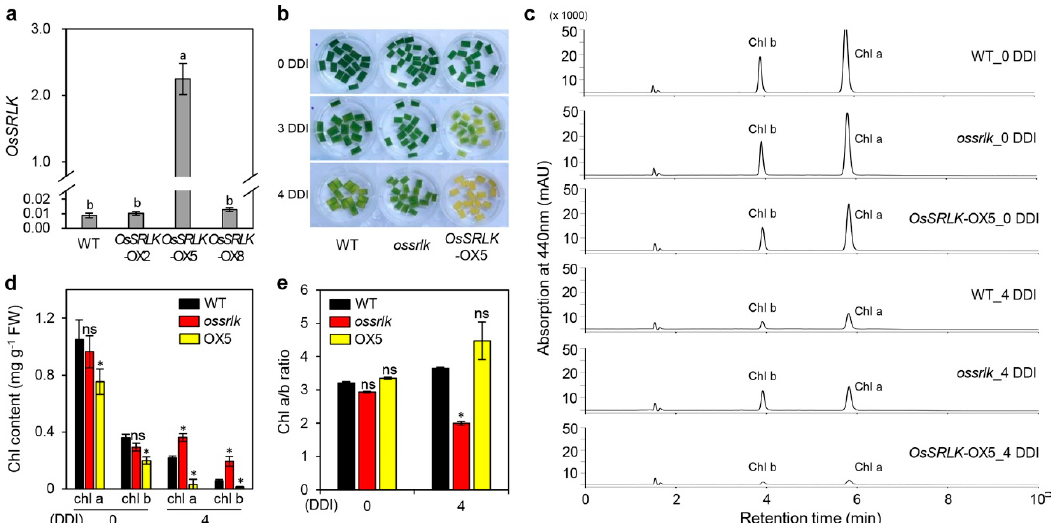
Figure 3. Overexpression of OsSRLK promotes chlorophyll degradation during DIS. ( a ) Expression of OsSRLK in the flag leaves of WT and transgenic lines grown in the paddy field under NLD conditions. The transcript levels were determined using RT-qPCR and normalized to those of OsUBQ5 . Mean and standard deviations were obtained from more than three biological replicates. Different letters indicate significant differences according to one-way ANOVA and Duncan’s least significant multiple range test ( p < 0.05). ( b – e ) Detached leaves of WT, ossrlk , OsSRLK -OX5 plants grown in the paddy soil for three weeks were incubated in 3 mM MES (pH 5.8) under complete darkness at 28 °C. ( b ) The leaf yellowing phenotypes were observed at 0, 3, and 4 DDI. ( c ) HPLC elution profiles of chlorophyll a (Chl a ) and chlorophyll b (Chl b ). Absorbance at 440 nm were measured in detached leaves of WT, ossrlk , and OsSRLK -OX5 at 0 and 4 DDI. The same weight of detached leaves was extracted with the same volume of 80% acetone. The same volume of extract was loaded in each injection. Measurements of peak areas using HPLC analysis were used for determining the contents ( d ) and ratios ( e ) of Chl a and Chl b . Mean and standard deviation values were obtained from three biological repeats. Asterisks on ossrlk or OsSRLK -OX5 indicate a significant difference from WT, as determined by Student’s t -test (* p < 0.05). ns, not significant; FW, fresh weight. These experiments were repeated thrice with similar results.